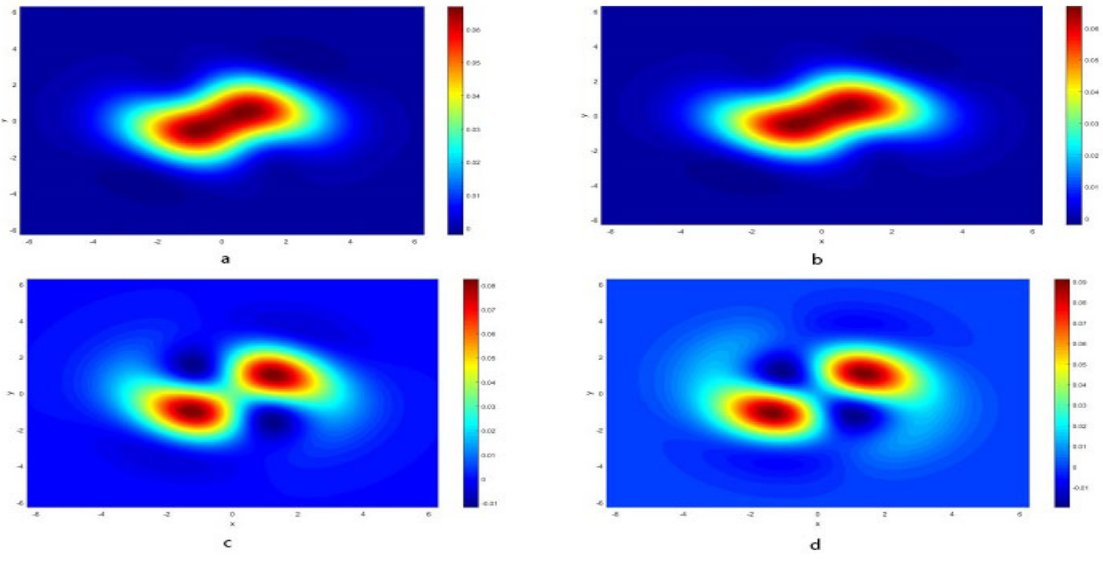
Fig. 6 Vorticity distribution for great values of α where a) at time t = 6, K T = 1 / 500, ν = 1 / 500, and m = 4, b) at time t = 6, K T = 1 / 1500, ν = 1 / 500, and m = 4, c) at time t = 7, K T = 1 / 500, ν = 1 / 500, and m = 4, d) at time t = 7, K T = 1 / 1500, ν = 1 / 500, and m =